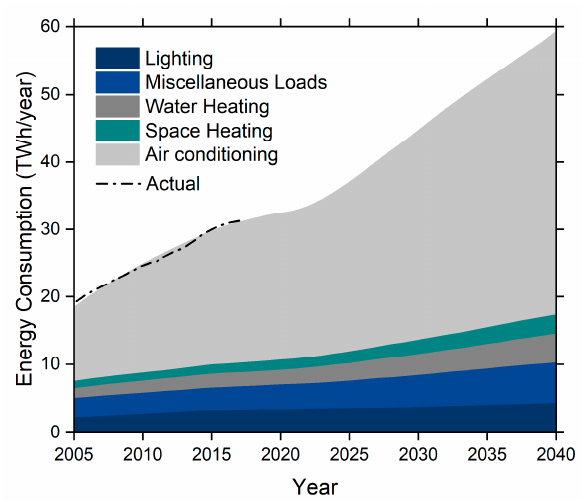
Figure 10. Forecast of on-site residential energy consumption by end-use until the year